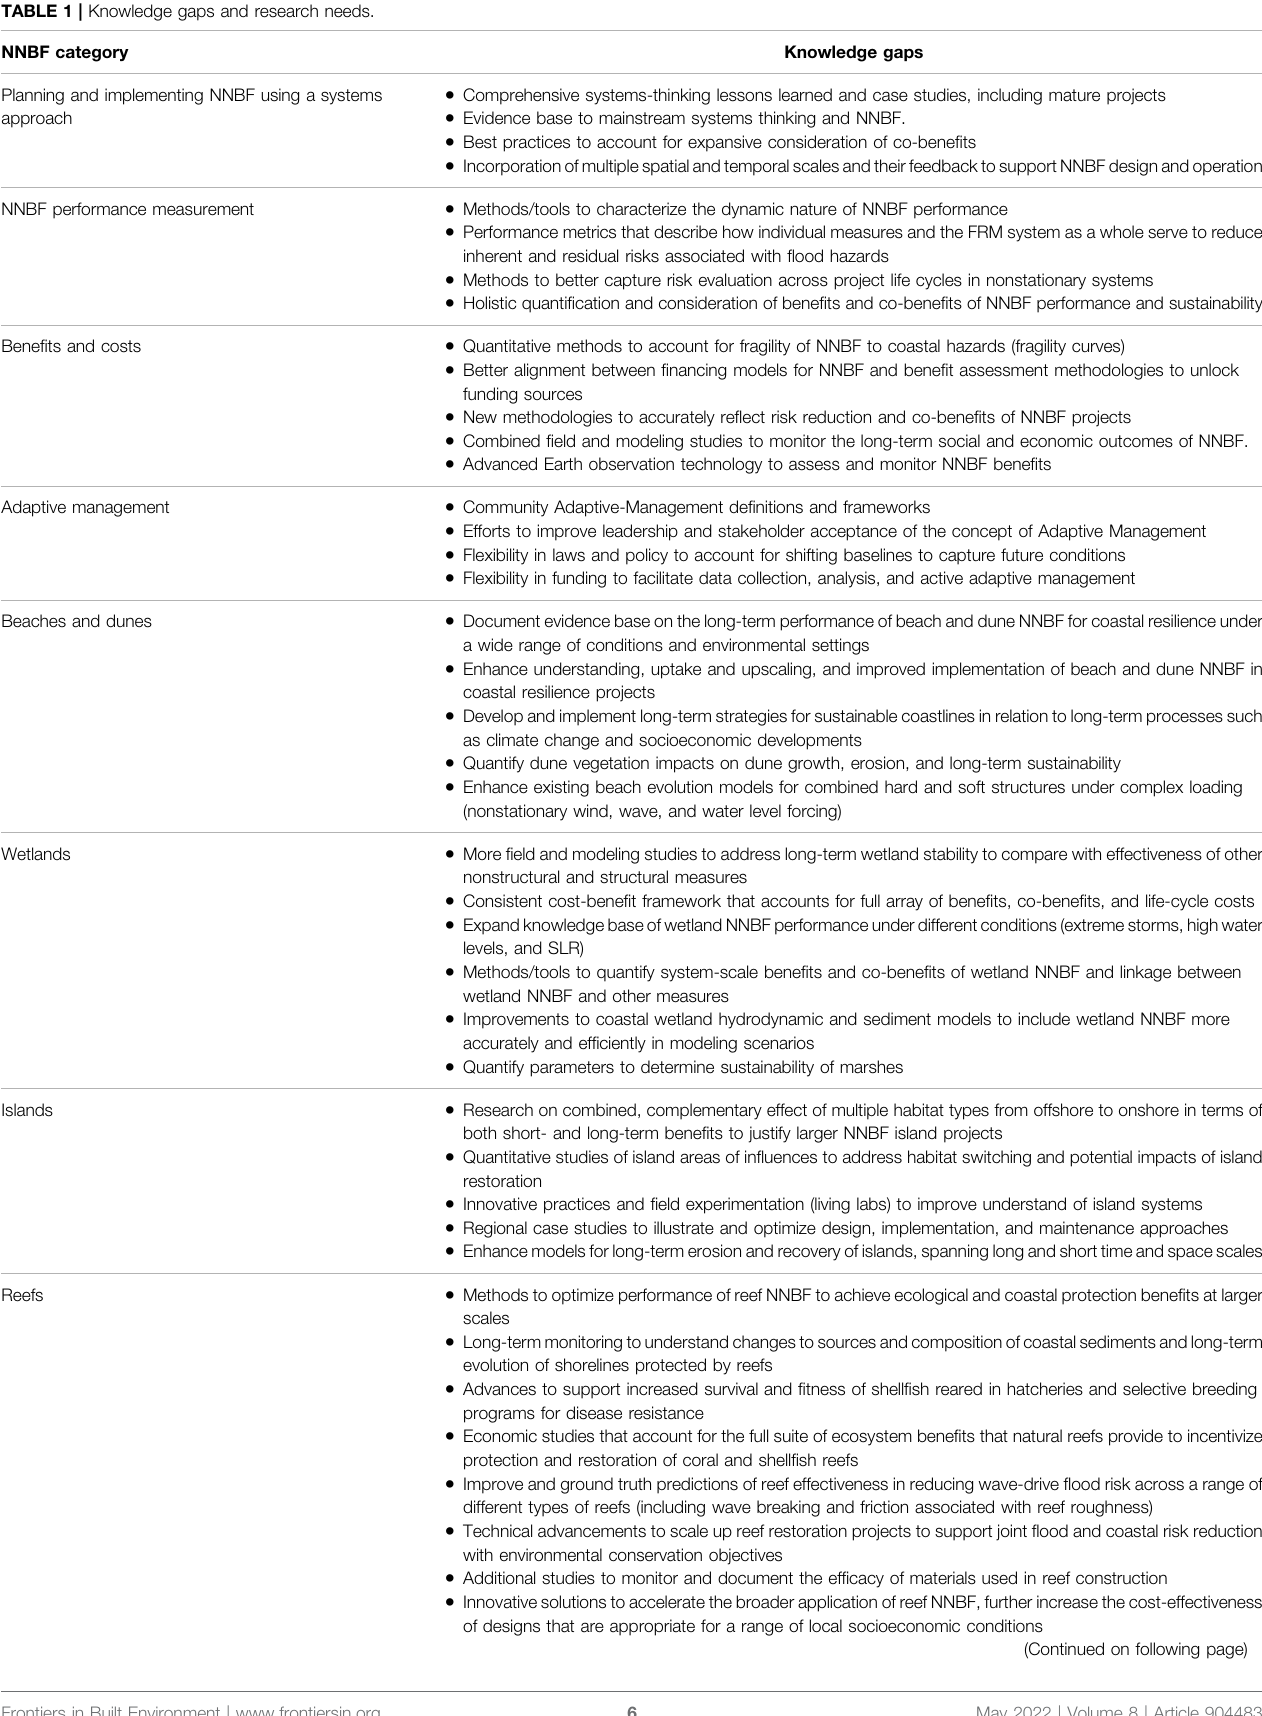
TABLE 1 | Knowledge gaps and research